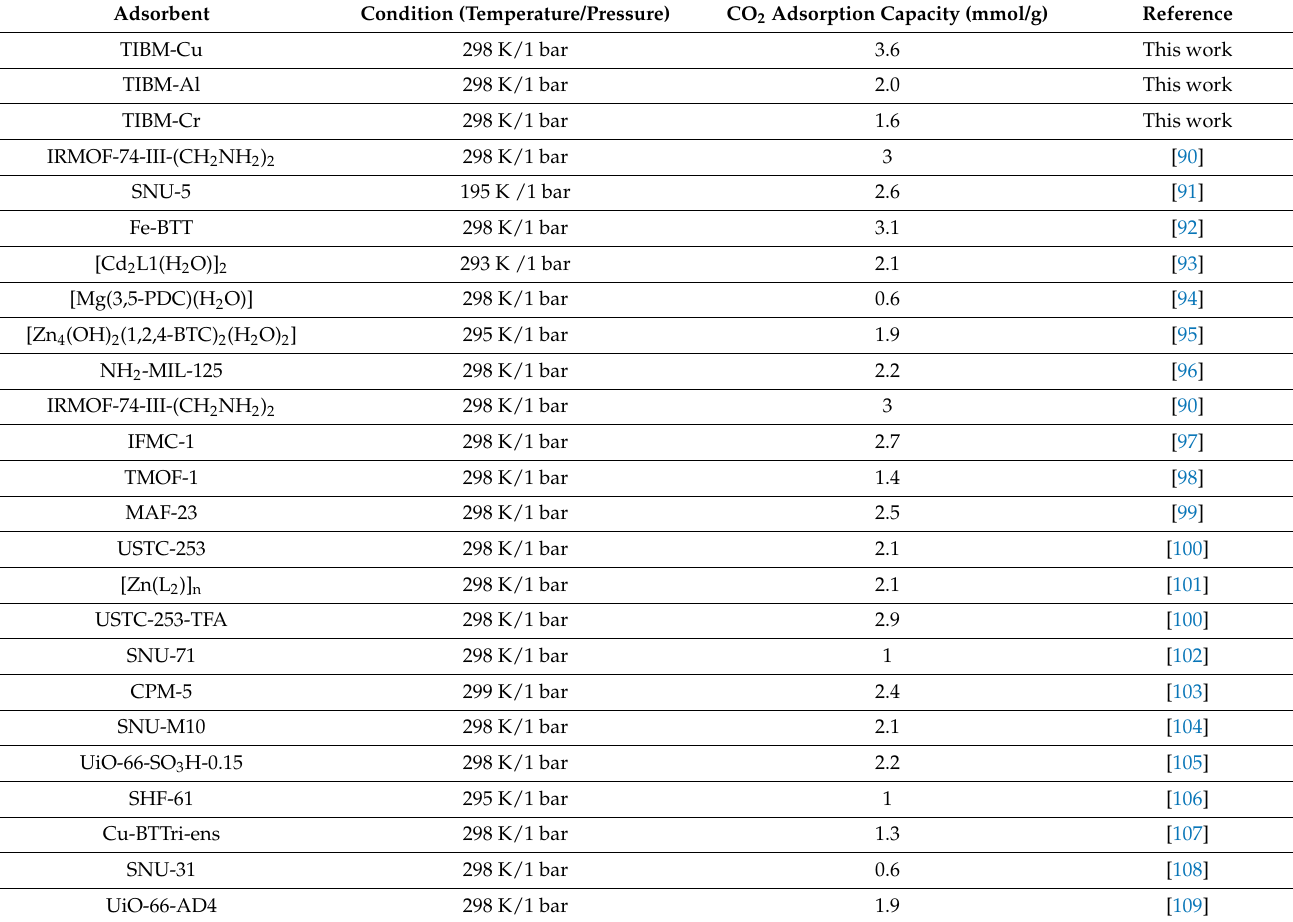
Figure 8. CO 2 adsorption capacity of TIBM-Cu MOF at increasing temperatures.